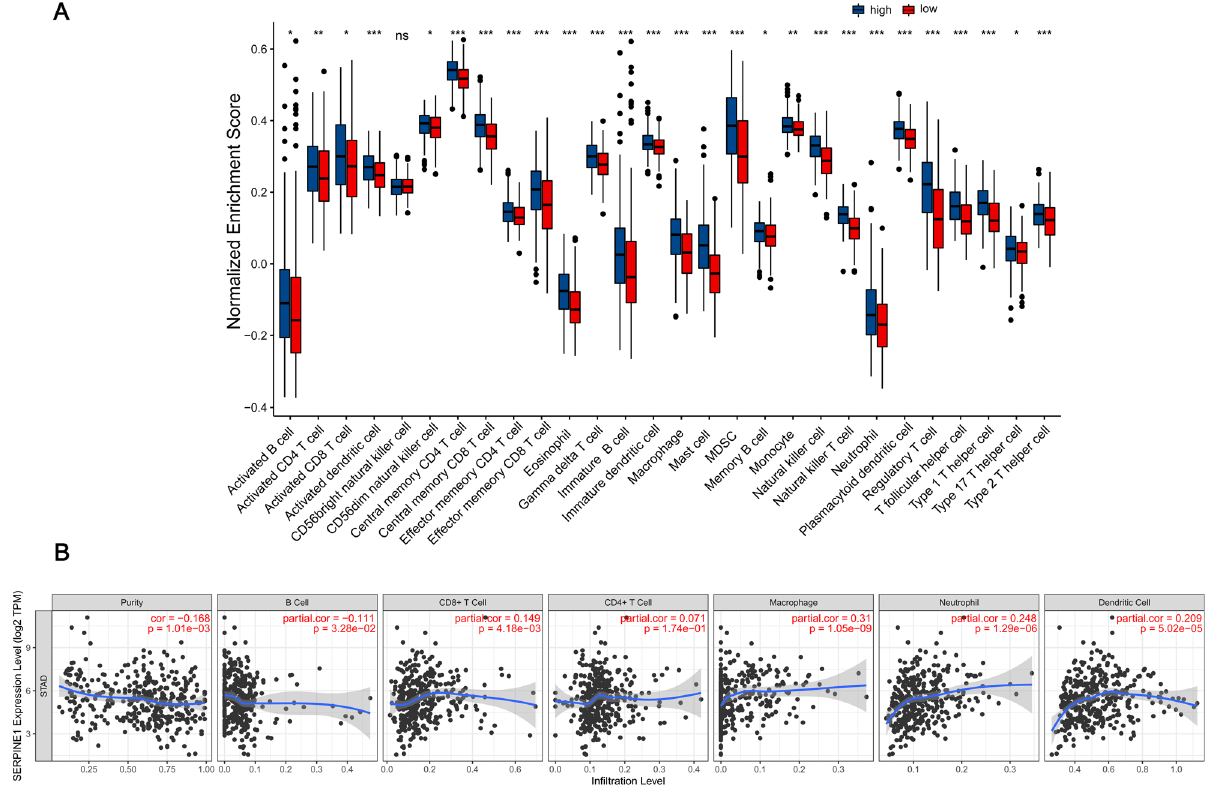
Figure 7. Expression and immunoinfiltration analysis of SERPINE1 in STAD. ( A ) The correlation between the expression of SERPINE1 and the expression of immune cells. ( B ) Correlation of SERPINE1 expression with immune infiltration level in